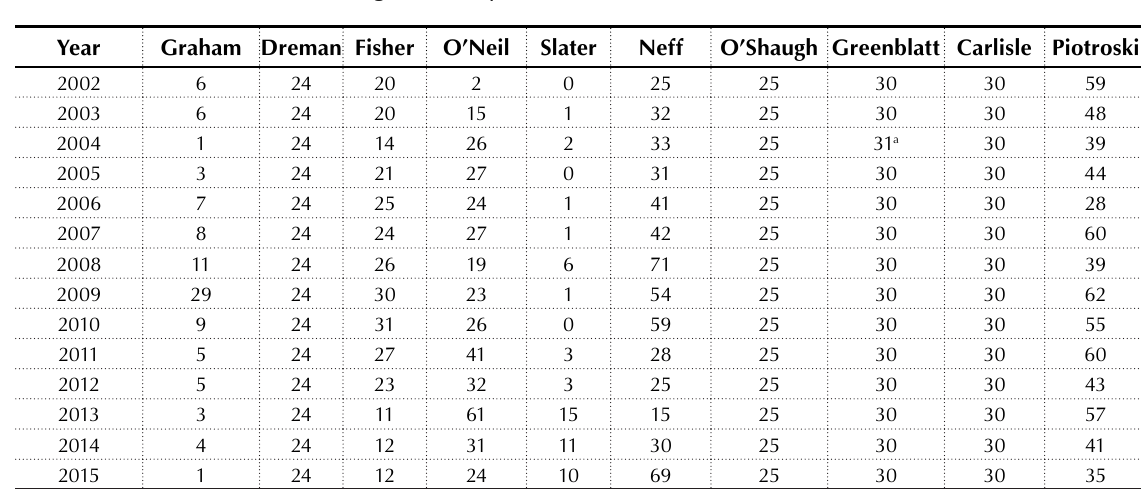
Table 2. Number of stock holdings in each portfolio